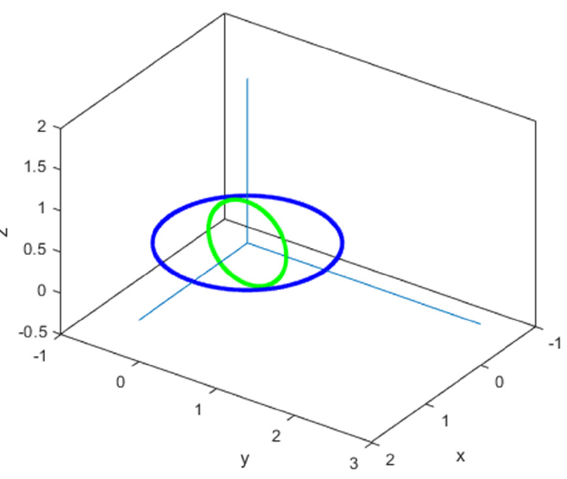
Figure 11. Case (c): two perpendicular circular loops. Not a singular case, ( a = 1, b = c = 0, L = l = 1).